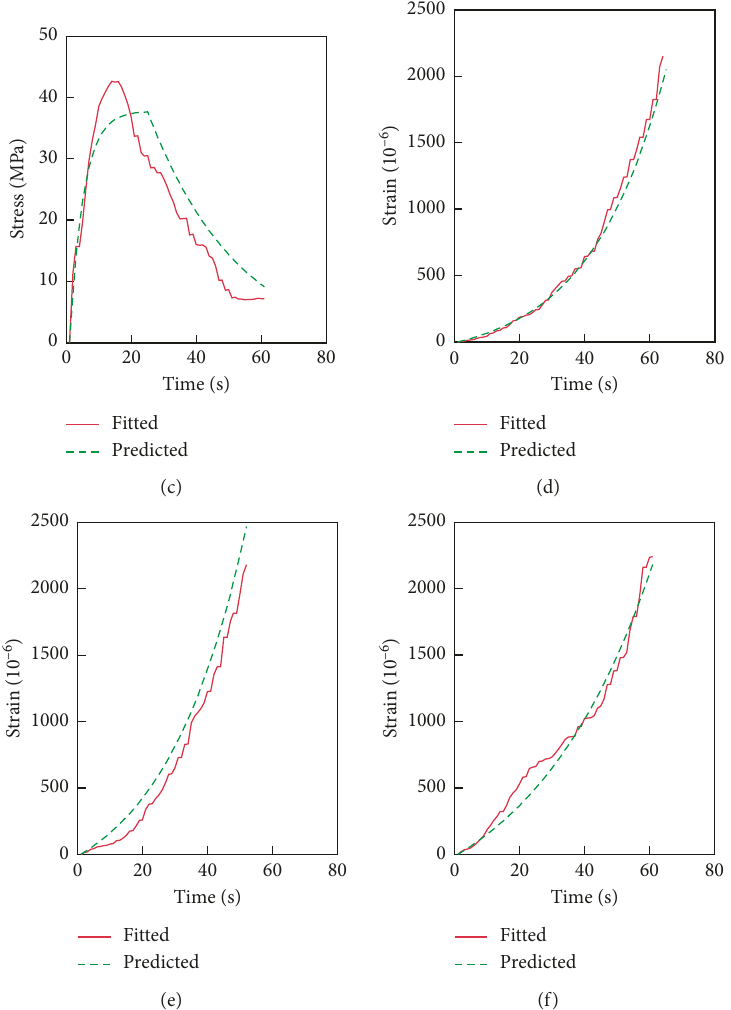
Figure 13: Prediction of each fitted stress and strain series. (a) Stress of Group 1. (b) Stress of Group 2. (c) Stress of Group 3. (d) Strain of Group 1. (e) Strain of Group 2. (f) Strain of Group 3.